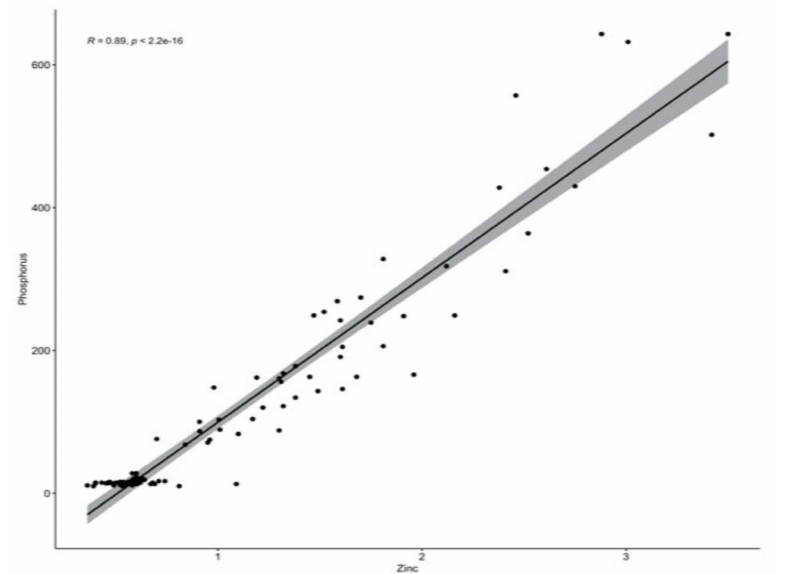
Figure 6. P (ppm) × Zn (ppm), Spearman’s correlation for Trifolium incarnatum soils.